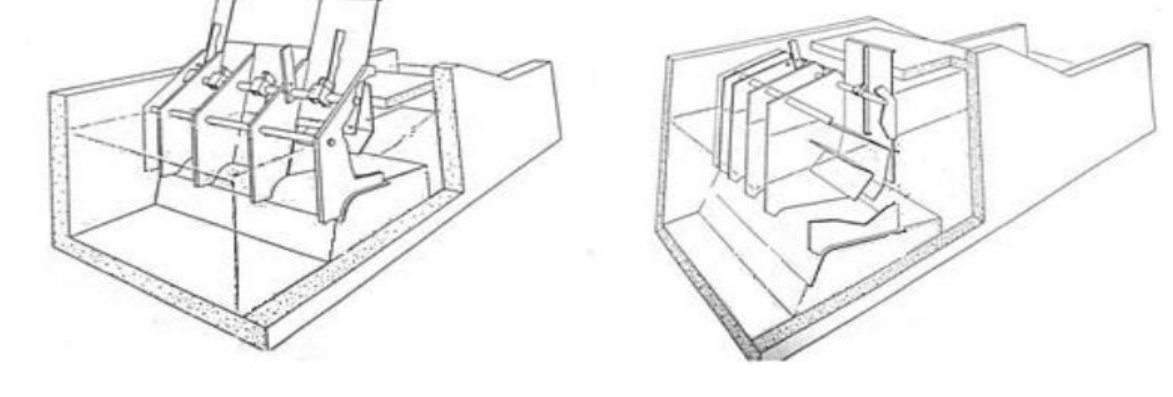
Fig. 2 View of Neyrpic